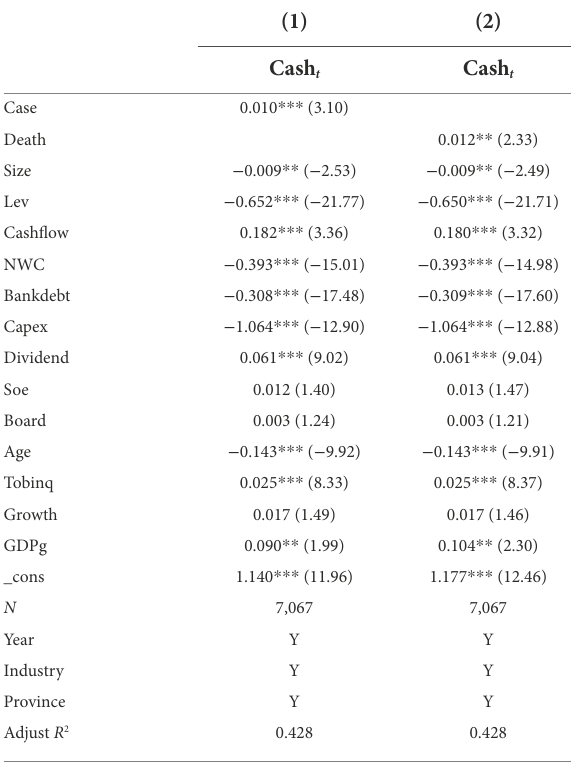
TABLE 4 COVID-19 impact and corporate cash holdings: a measure of changing independent variables.